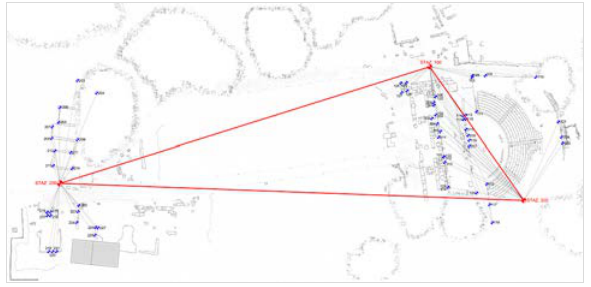
Figure 4. Topographic survey with total station